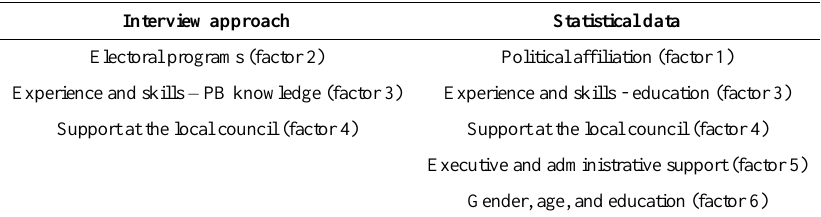
Table 2. Research approaches by